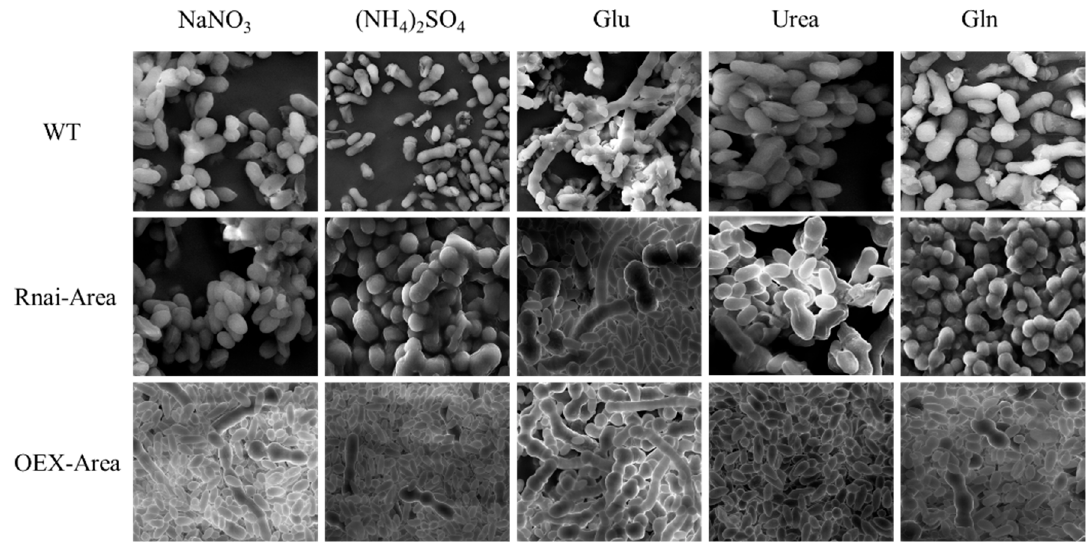
Figure 9. SEM of mutant strains culturing with different nitrogen sources.